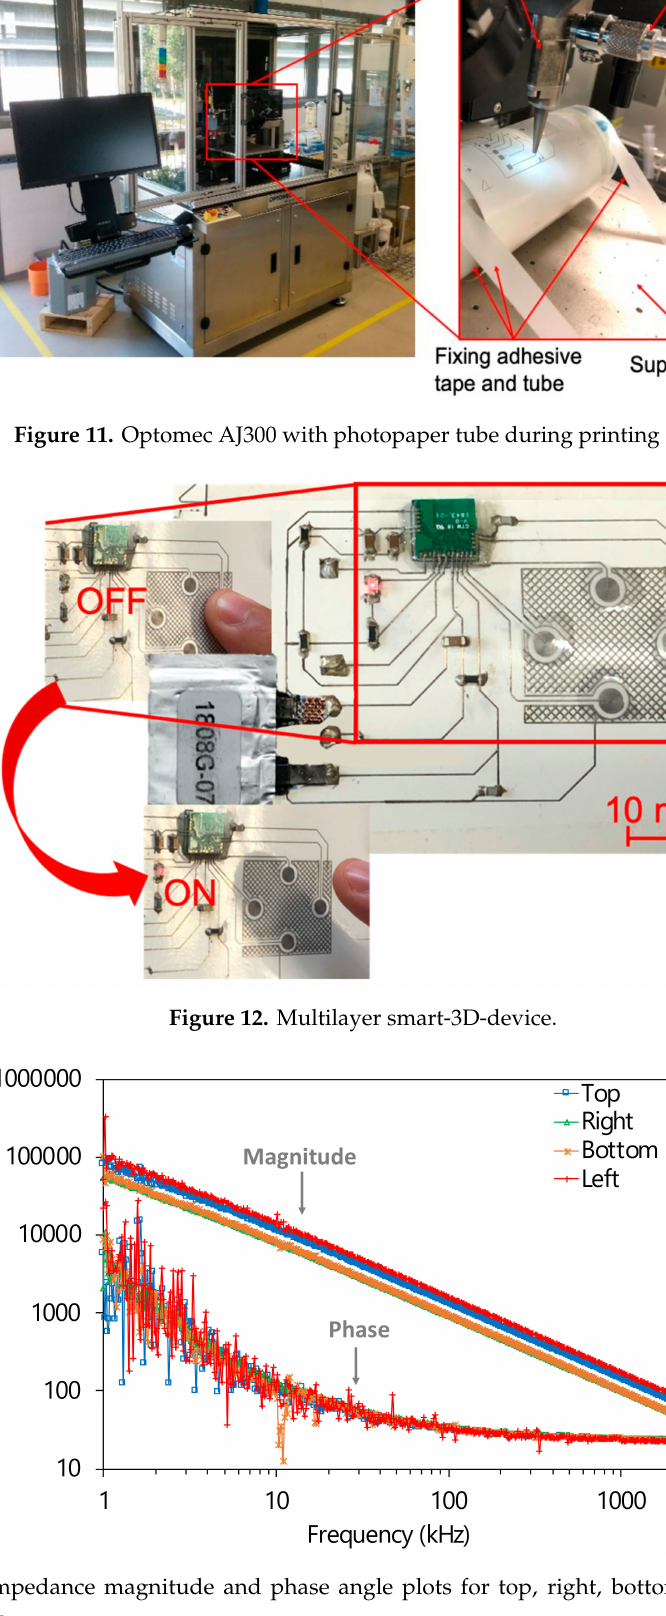
Figure 13. Impedance magnitude and phase angle plots for top, right, bottom, and left keys in no-finger